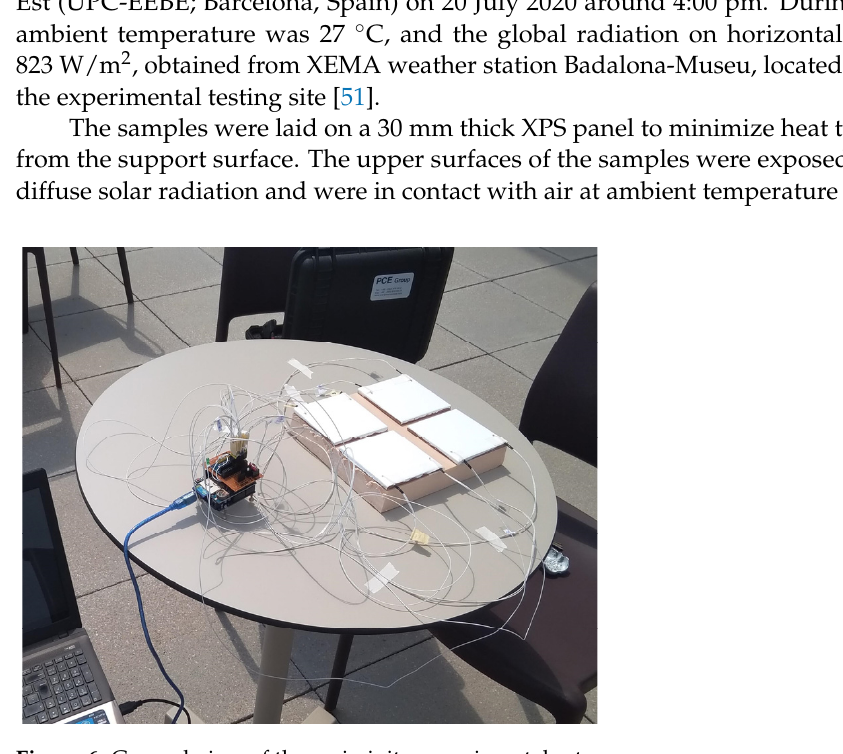
( b ) Figure 7. Position of NTC sensors ( a ), and thermographic picture E10 after adjusting the emissivity ( b ). Table 3. Technical specifications of the measuring devices used [52,53]. Device Model Accuracy Measuring Range Resolution Thermistor 0.15 °C After synchronizing the clocks of the thermographic camera and the Arduino UNO board, a series of thermographic pictures of the samples were taken in order to estimate the emissivity of the photocatalytic coating at ambient temperature. At the same time, surface temperatures measured by the thermistors were recorded by the Arduino UNO board. The time stamp on the thermographic pictures was used to retrieve the correspond- ing measured temperature data. The NTC recorded temperature data was used to adjust the sample’s emissivity reading using the camera’s data processing software (e.g., Figure